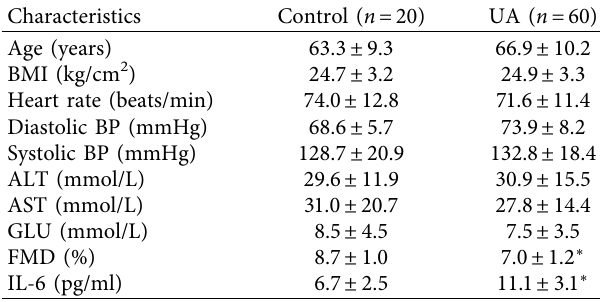
Table 1: Clinical and biochemical characteristics of the two groups.